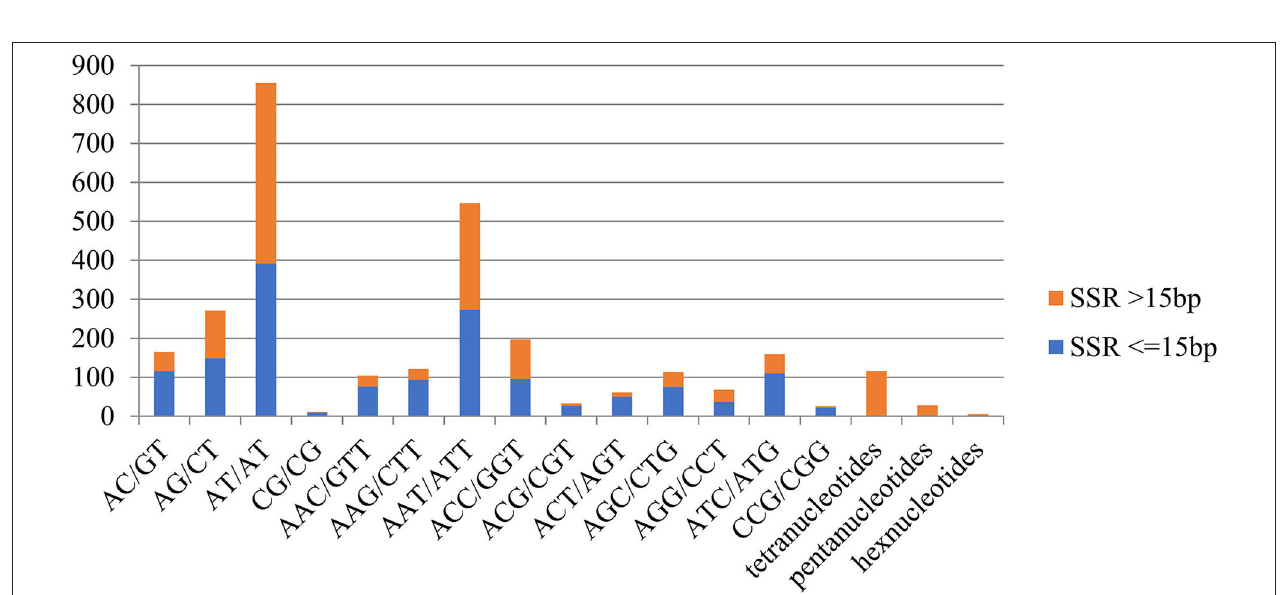
FIGURE 7 | Distribution of simple sequence repeat (SSR) nucleotide classes among different nucleotide types found in the transcriptome of M. aurolineatus .